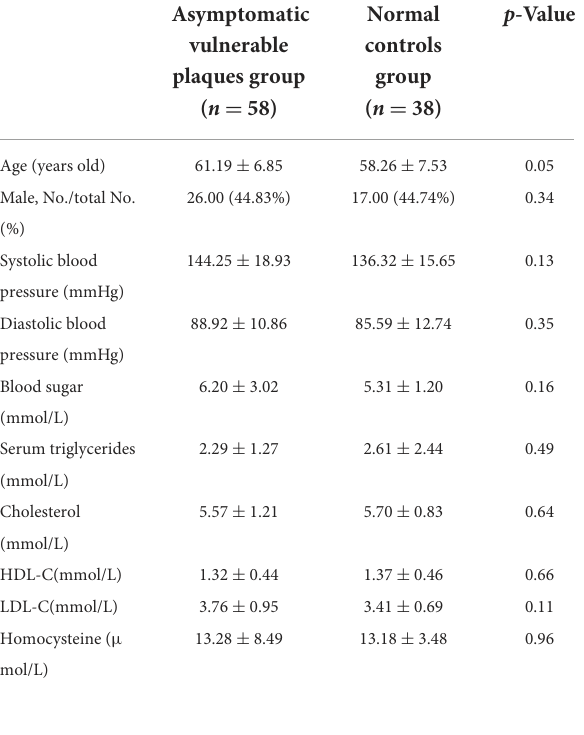
TABLE 1 Demographic and clinical data.